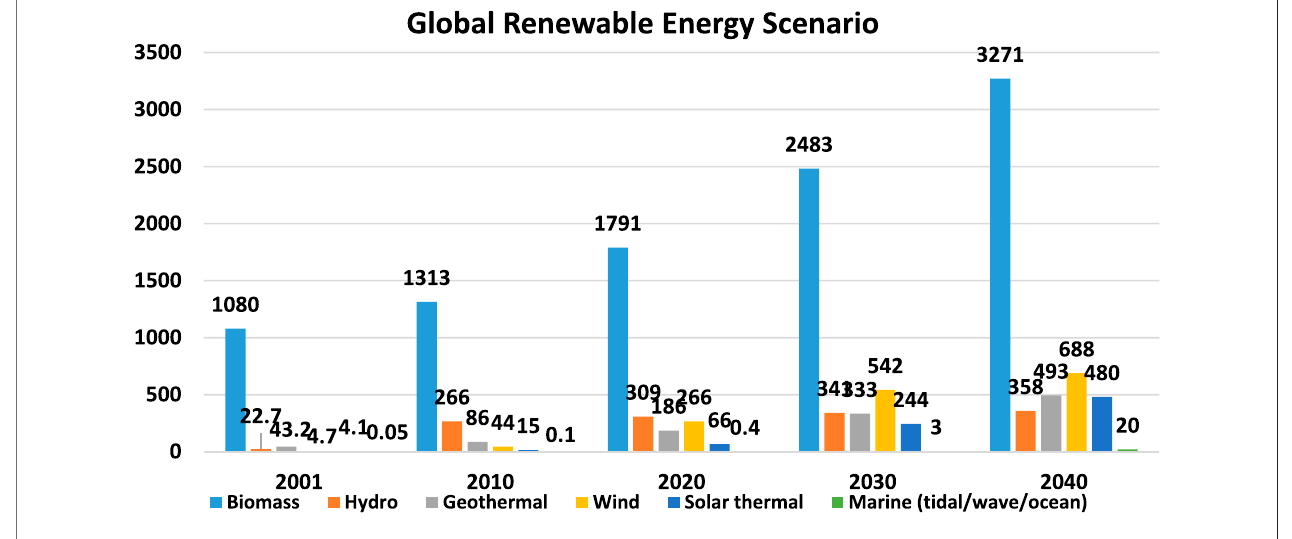
FIGURE 1 | Global renewable energy scenario by